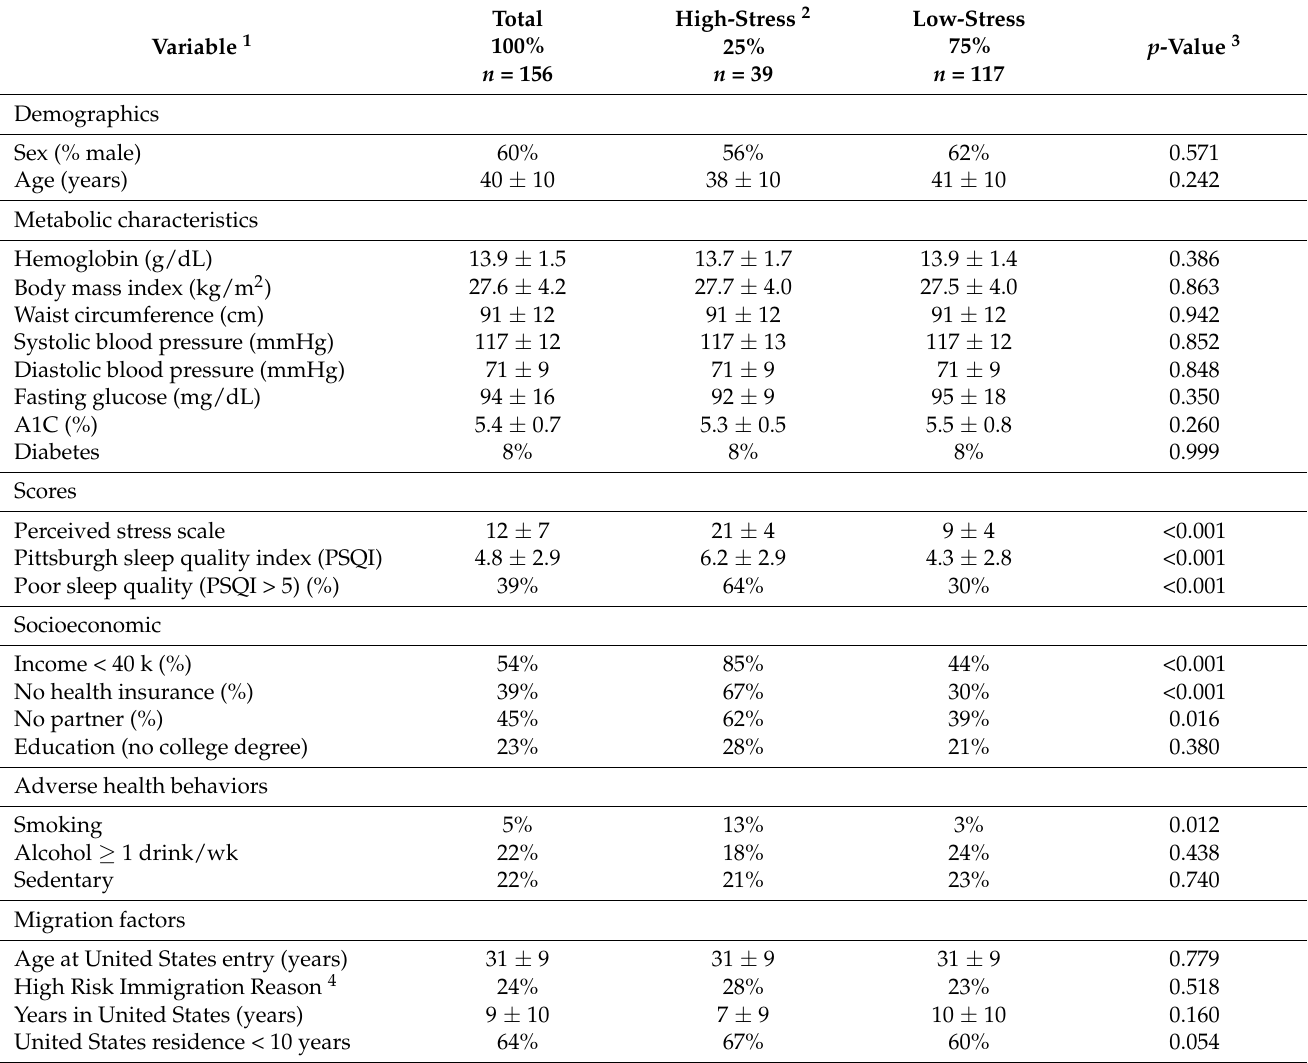
Table 2. Characteristics According to Stress Group.